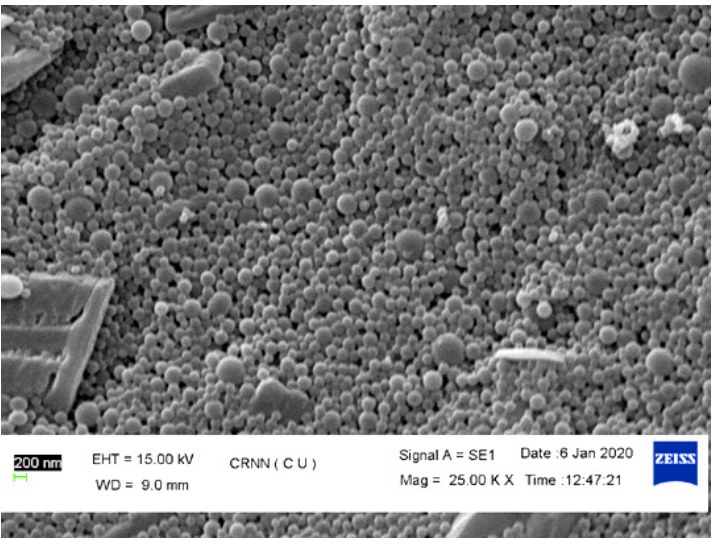
Figure 3. SEM image of Kaempferol nanoparticle (DNP-7).